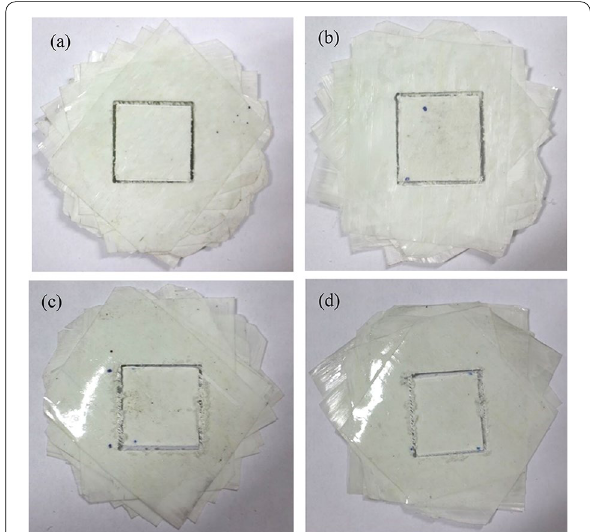
Fig. 3 Biomimetic composite laminates with different helix angles. a Sample with fiber helix angle of 15º, b sample with fiber helix angle of 30°, c sample with fiber helix angle of 60°, and d sample with fiber helix angle of